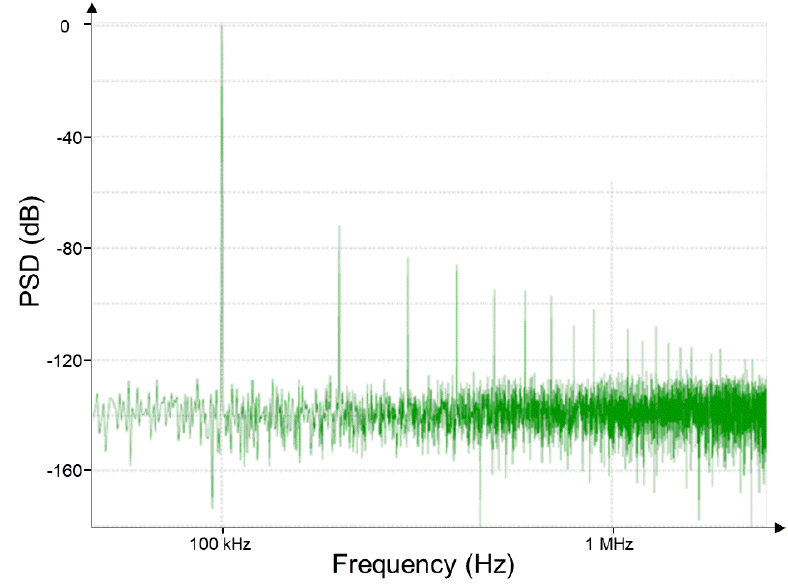
Figure 10. Simulated power spectrum density (PSD) of the proposed sample and hold circuit.